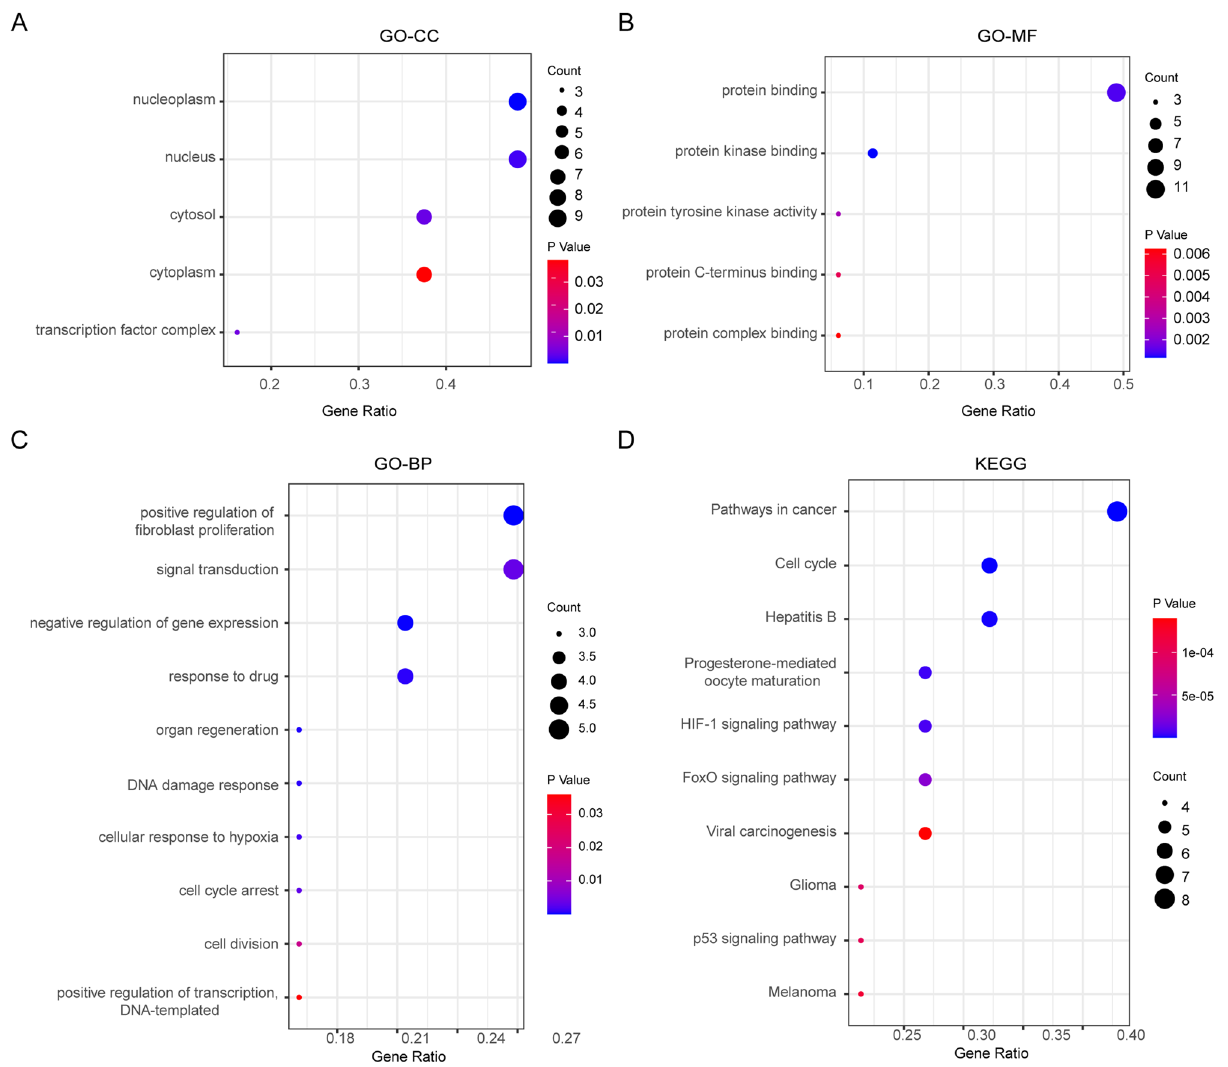
Figure 4. Functional enrichment of the key target genes. ( A ) Enriched cellular components. ( B ) Enriched molecular functions. ( C ) Enriched biological processes. ( D ) Enriched KEGG pathways. [Fig. 4 was drawn by Sangerbox tools (http:// sange rbox. com/ AllTo ols? tool_ id= 96979